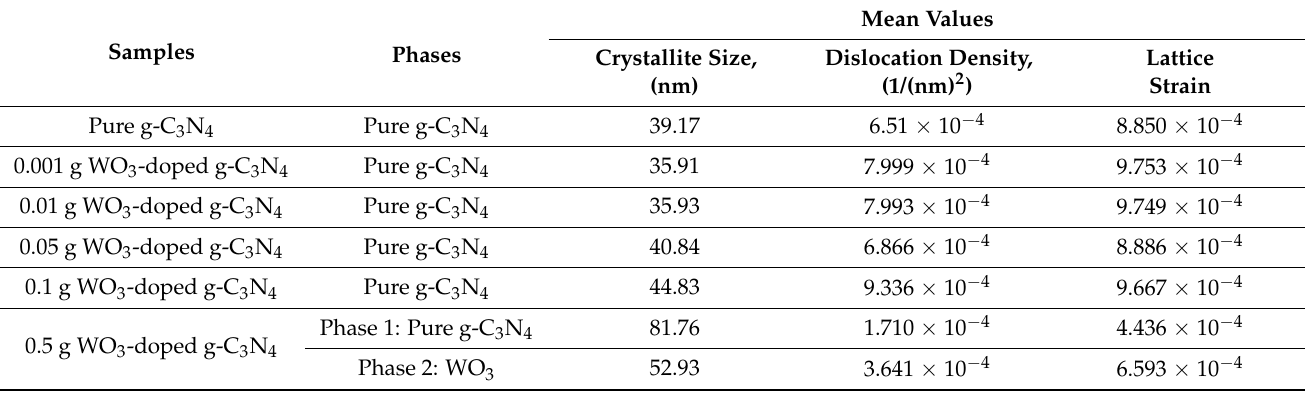
Table 1. N 4 and its WO 3 /g-C 3 N 4 with various amounts of tungsten oxide (0.001, 0.01, 0.05, 0.1, and 0.5% WO 3 ).